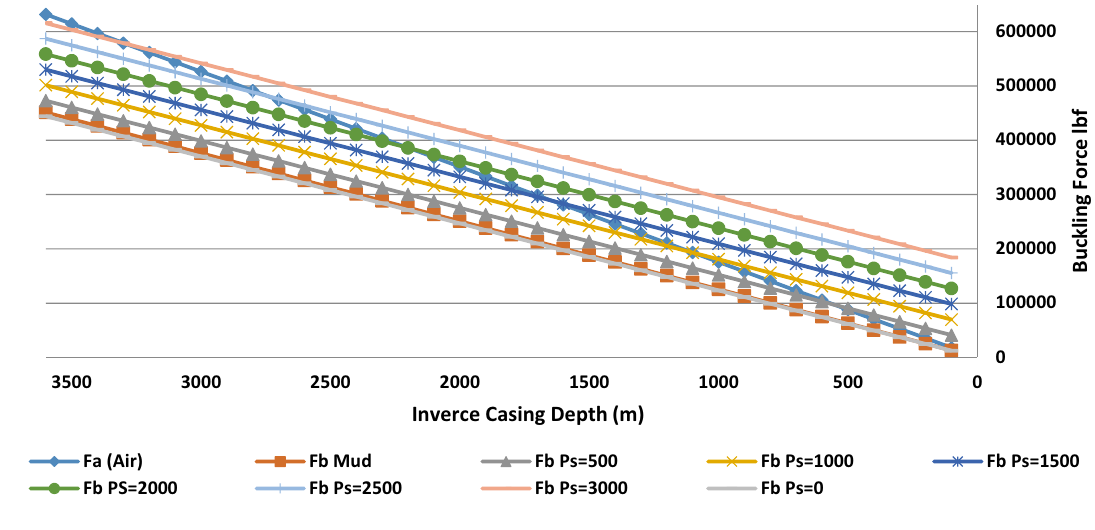
Fig. 6 Variation of additional buckling force compared to casing depth (9 ″ 5/8 (53.5#) casing)